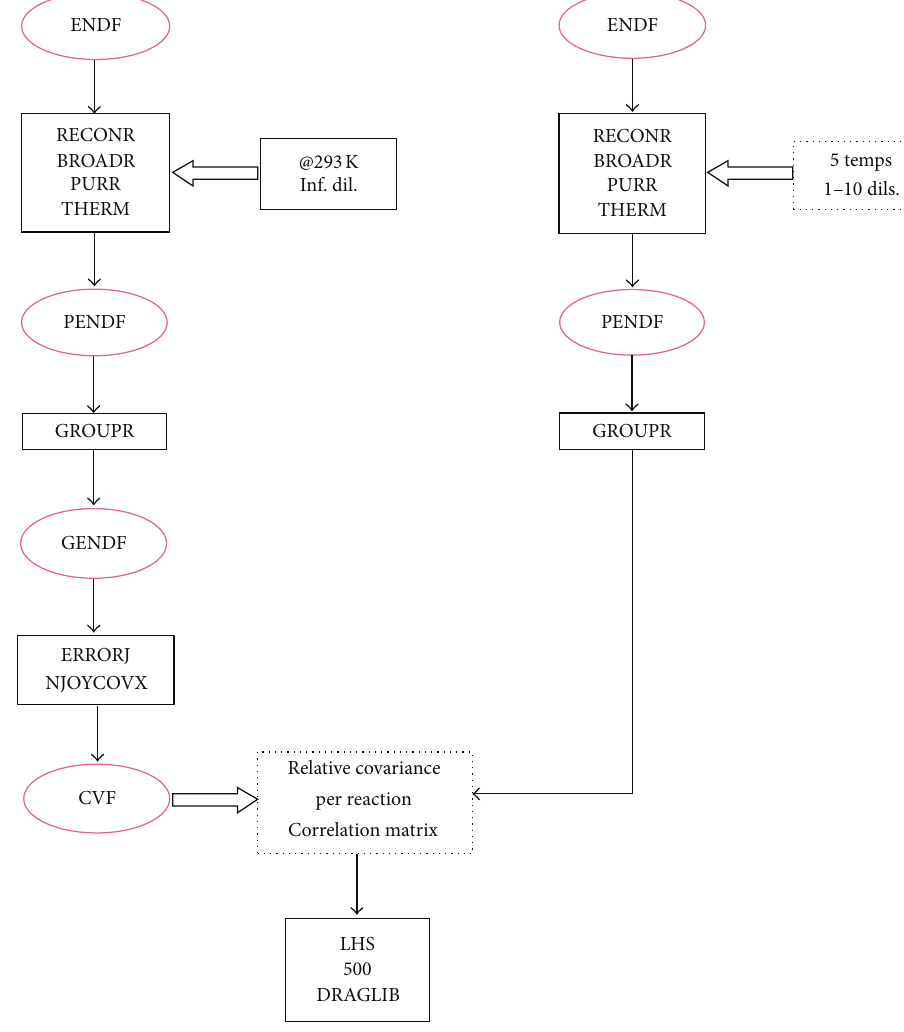
F 12: DRAGLIB statistical perturbation